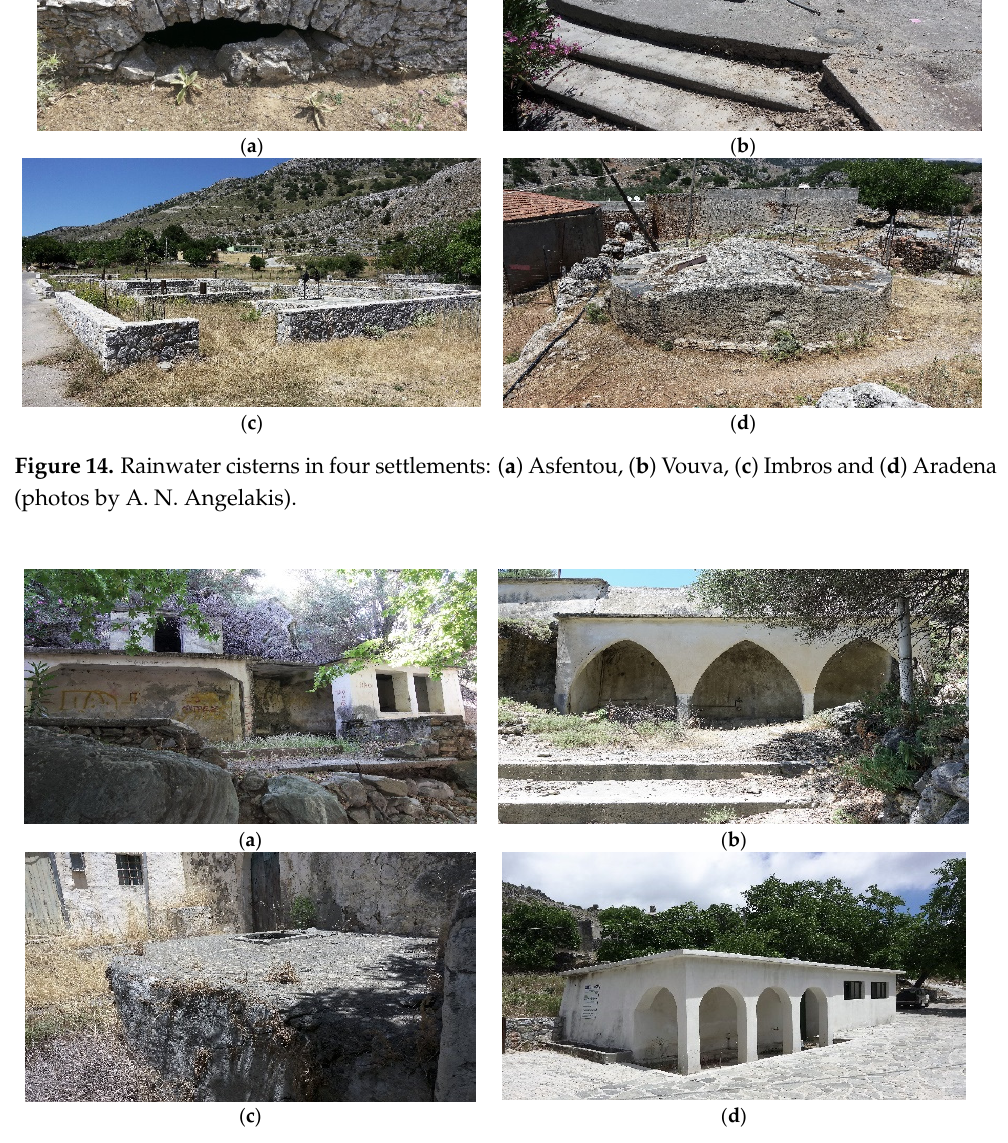
Figure 15. Water supply of settlements at low altitudes: ( a ) fountain in Argoules, ( b ) fountain Kapsodasos, ( c ) rainwater cistern Kapsodasos and ( d ) fountain in Kallikratis (photos by A. N. Angelakis).